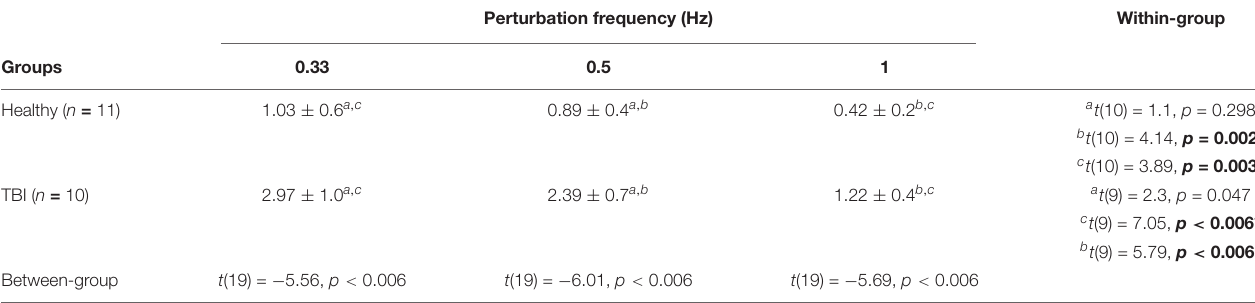
TABLE 2 | Results of post-hoc analysis for between-group and within-group comparison of the PPT outcome (mean ± sd).